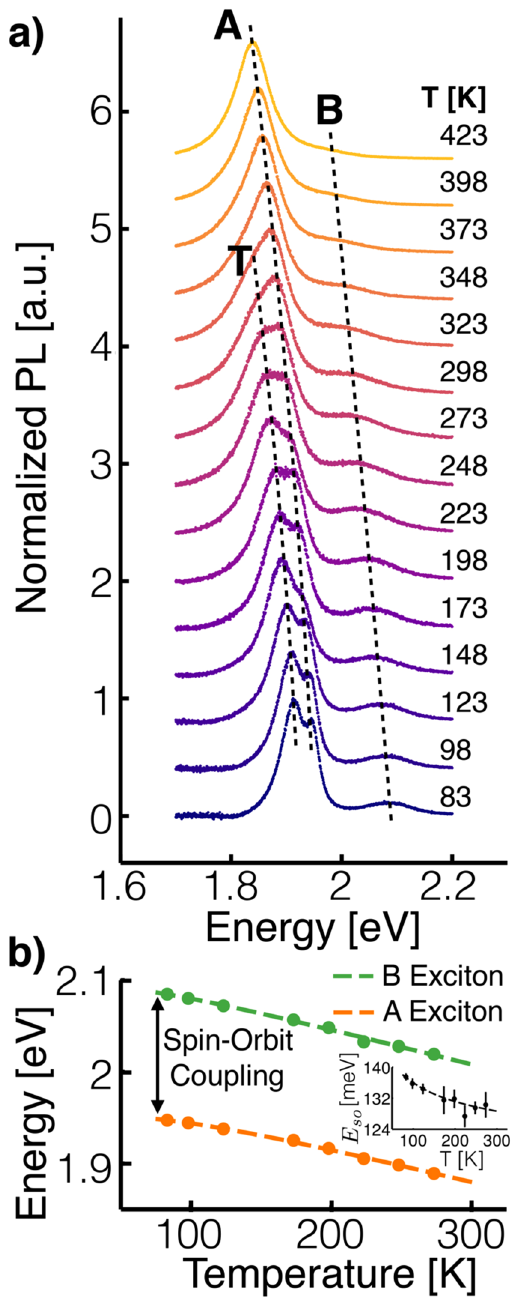
Figure 3. ( a) Monolayer MoS 2 PL spectra measured from 83 K to 423 K. The background has been removed from the spectra, and the spectra have been normalized to make features easily visible. Guides to the eye for the trion, A exciton and B exciton peak positions are included for clarity. ( b) A exciton and B exciton peak positions versus temperature and best-fit to a semi-empirical model 14,15 . For most data points the error bars are smaller than the symbols. Inset: Temperature dependent spin-orbit splitting between A and B exciton